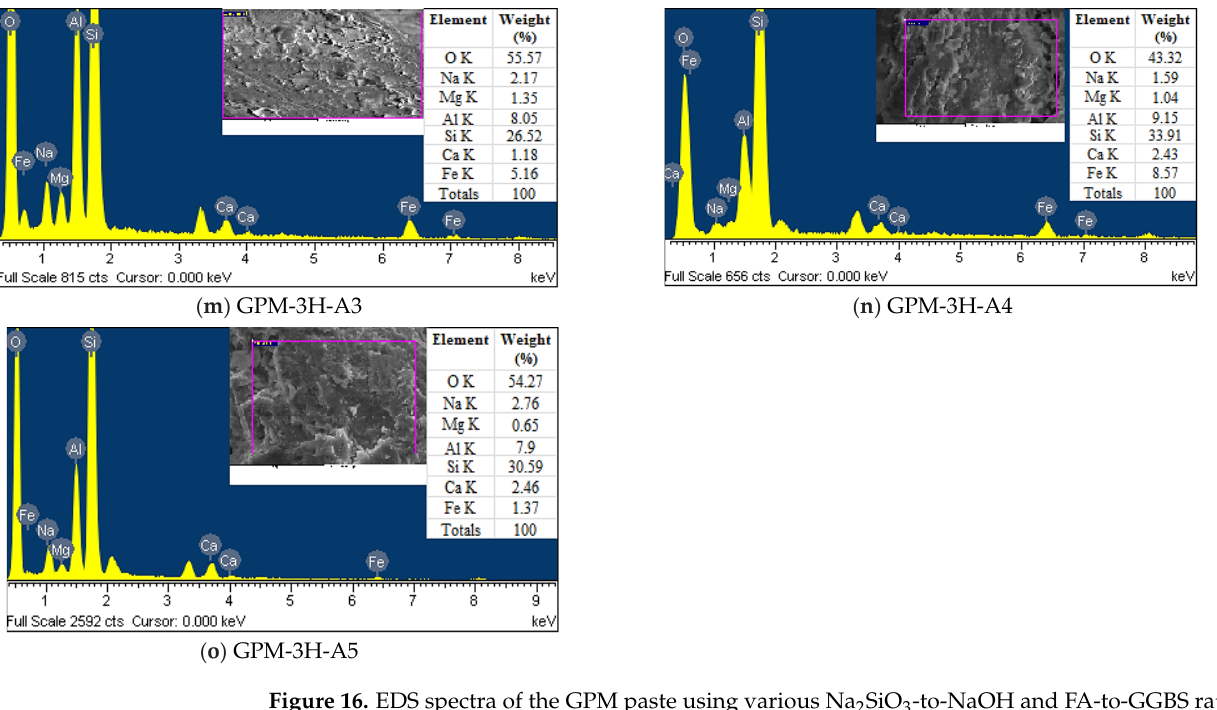
Figure 16. EDS spectra of the GPM paste using various Na 2 SiO 3 -to-NaOH and FA-to-GGBS ratios with sand preheated at 110 °C and cured in a hot oven at a uniform temperature of 50 °C for 3 h and 1 d of room-temperature curing: ( a ) GPM-3H-C1; ( b ) GPM-3H-C2; ( c ) GPM-3H-C3; ( d ) GPM-3H-C4; ( e ) GPM-3H-C5; ( f ) GPM-3H-B1; ( g ) GPM-3H-B2; ( h ) GPM-3H-B3; ( i ) GPM-3H-B4; ( j ) GPM-3H-B5; ( k ) GPM-3H-A1; ( l ) GPM-3H-A2; ( m ) GPM-3H-A3; ( n ) GPM-3H-A4; ( o ) GPM-3H-A5 .